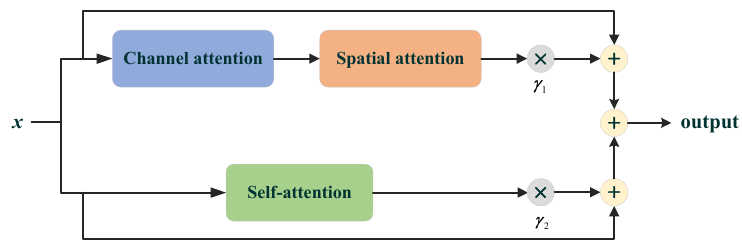
Figure 2. Schematic diagram of dual-path attention.